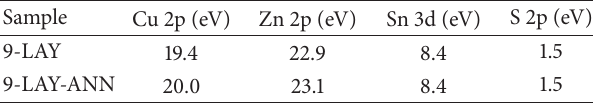
Table 3: Spin-orbit splitting values of CZTS films’ XPS